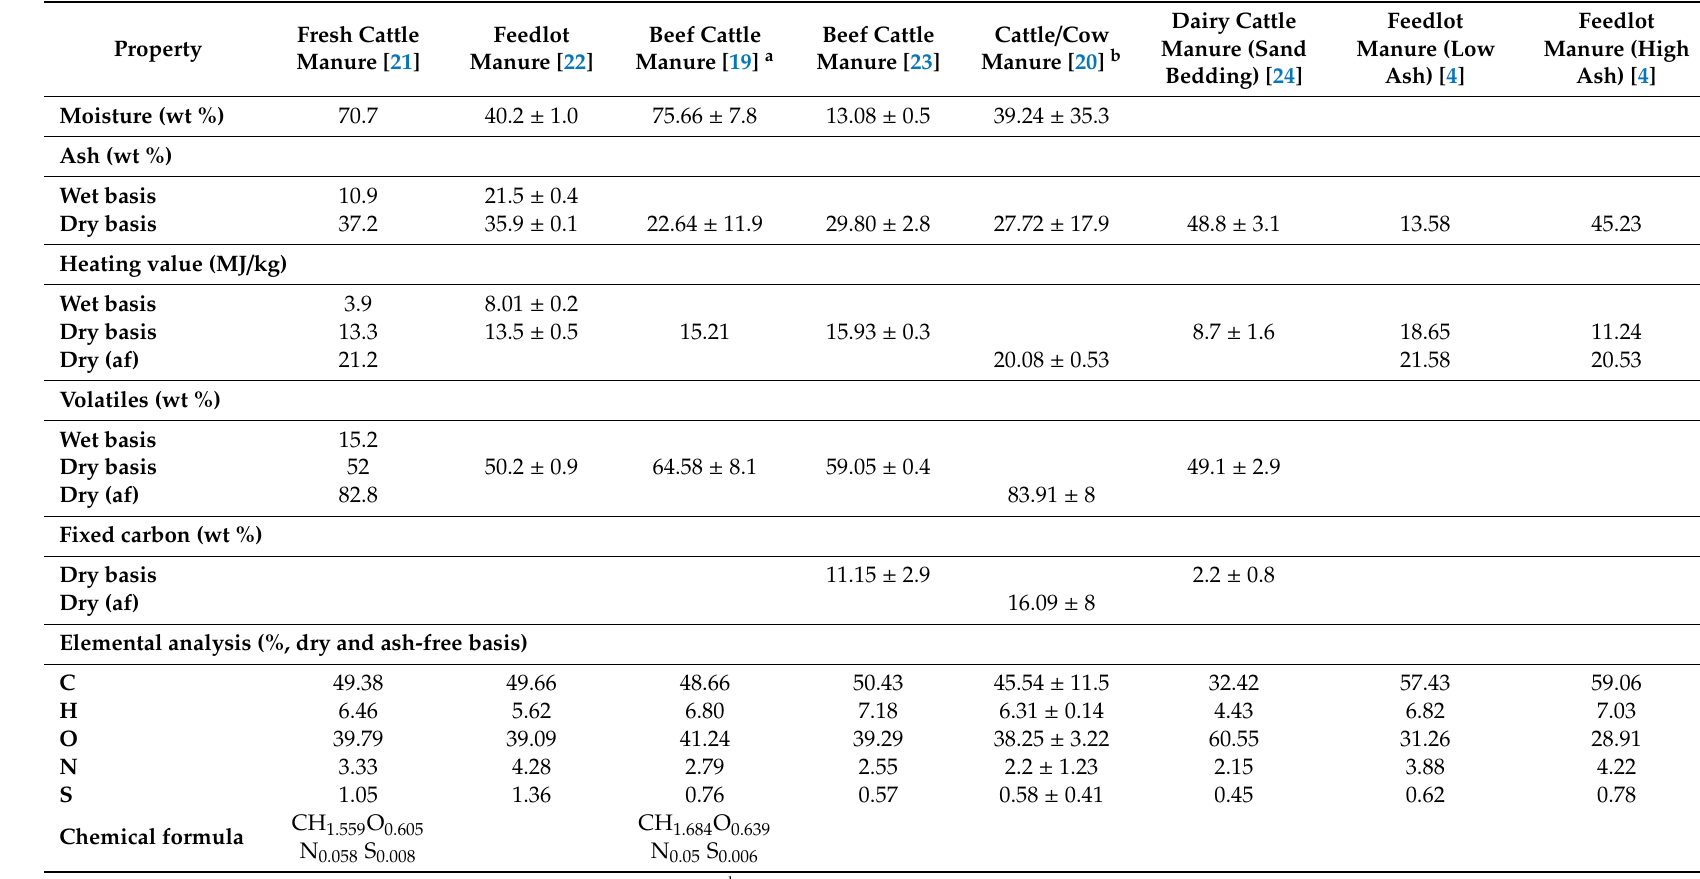
Table 2. Properties of cattle manure (wt